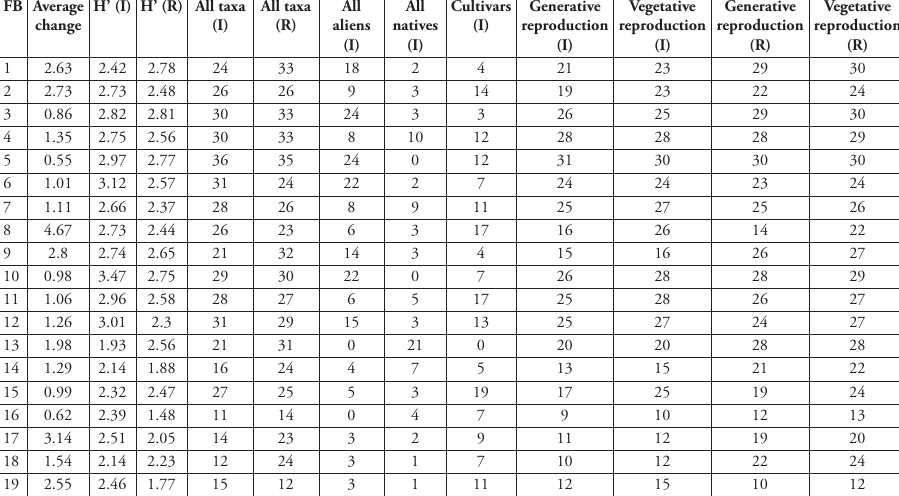
table 2. Average change of individual assemblages over the sampling period, based on the distance between initial (I) and recent (R) state in the CCA plot (see Methods for details on calculation), the Shan- non-Wiener index (H’) and numbers of taxa for different categories of origin and reproduction